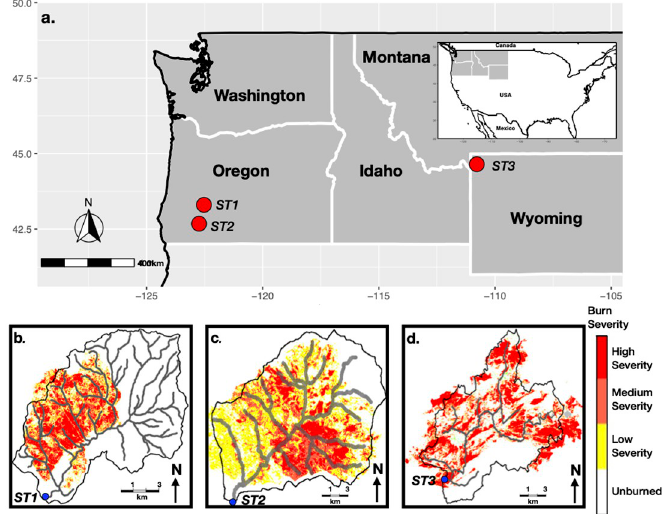
Fig 1. Location of studied stream sites and their burned watersheds. (a) Location of stream sites within the northwestern United States. The extent and severity of wildfire burn at (b) Elk Creek, (c) Boulder Creek, and (d) Gibbon River stream site watersheds. Blue filled circles represent the location of selected sites.